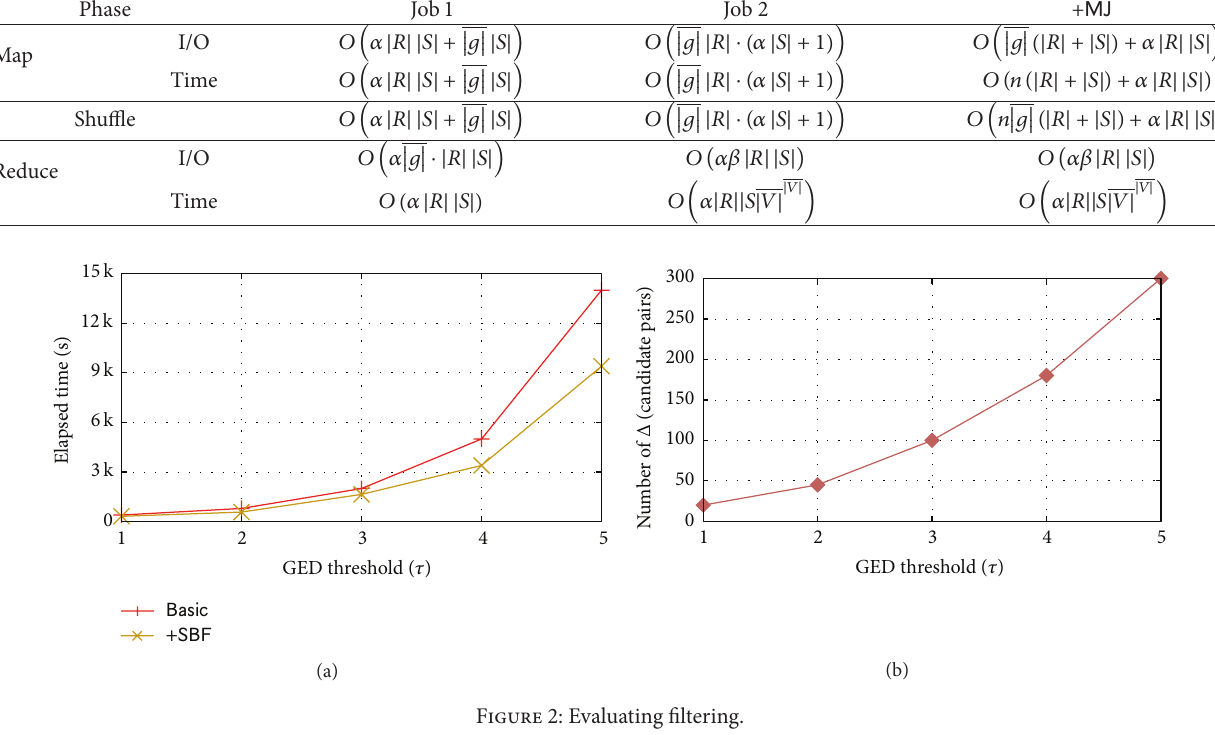
Figure 2: Evaluating filtering.